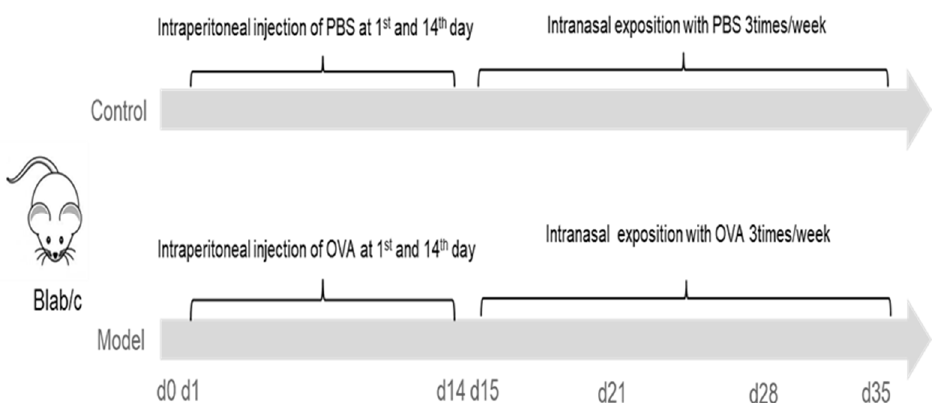
Figure 2. Eosinophil infiltration induction protocol. In the model group, at D1 and D14, mice were sensitized by intraperitoneal injection of 50 µ g OVA and 1 mg alum in PBS (50 µ g/1.0 mg/0.5 mL), and further challenged with 150 µ g OVA (50 µ L) intra-nasally, under the condition of anesthesia, 3 times per week for 3 weeks. Mice in the control group were sensitized and challenged with the same volume of PBS solution as the model group. OVA: ovalbumin.